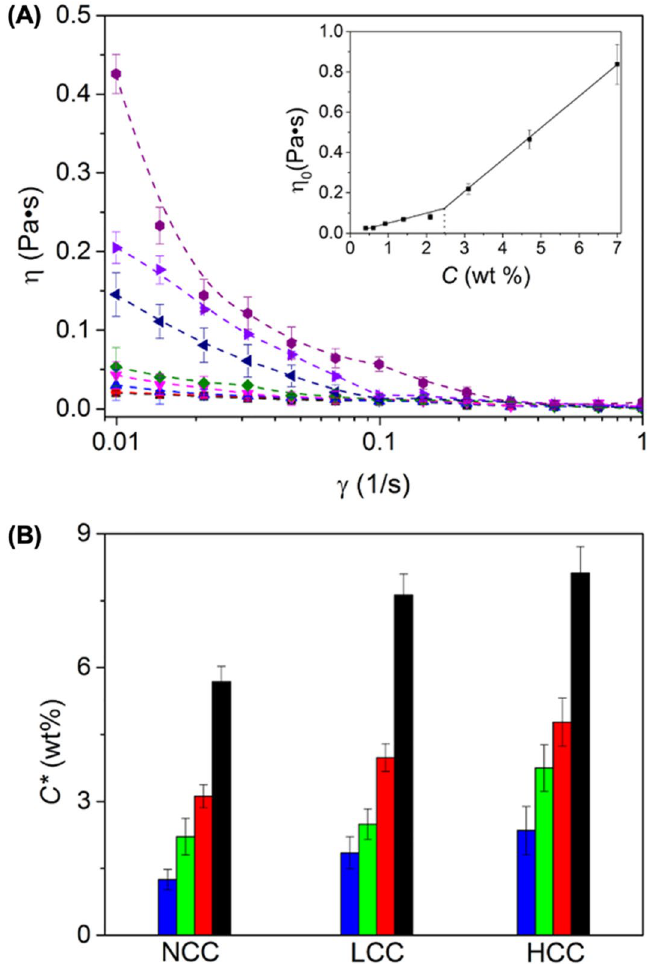
Figure 4. ( A ) Dynamic viscosity of suspensions of LWM NCC at concentrations ranging from 0.4 to 7.0 wt%. The inset represents the increase in the zero-shear viscosity (η 0 ) of the suspensions with the concentration of the colloids in suspension. ( B ) Influence of architecture and rigidity on the transition between the dilute and semi-dilute regime. Sphere (black); Short worm (red); Medium worm (green); Long worm (blue) for the uncrosslinked colloids (NCC), colloids with low crosslinking density (LCC) and colloids with high crosslinking density